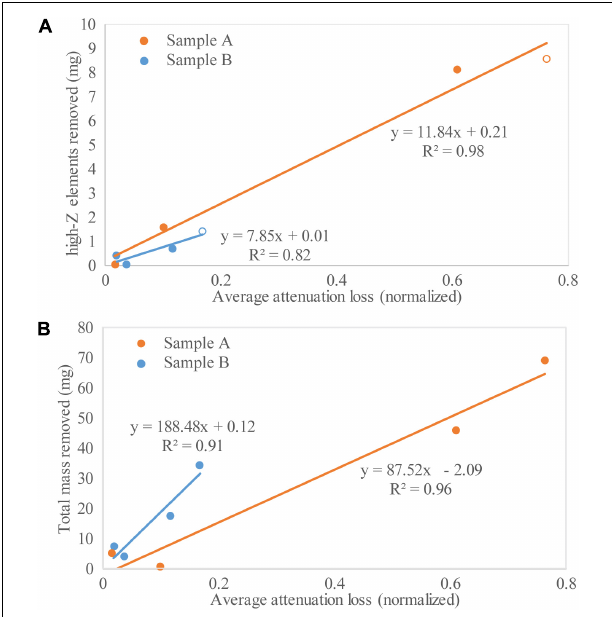
FIGURE 7 | High-Z elements removed (A) and total mass removed (B) during acid leaching steps vs. average normalized attenuation loss for both